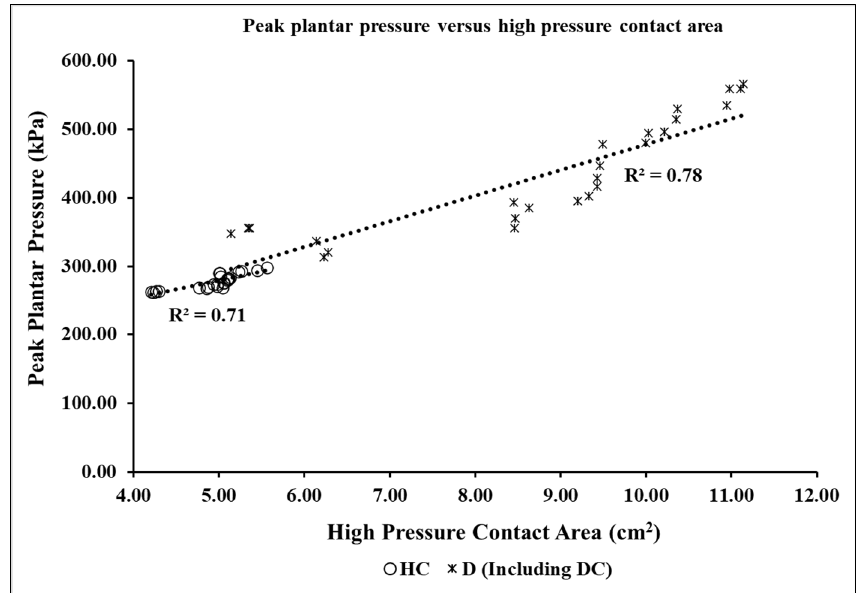
Figure 13. Correlation plot between the high-pressure contact areas and the peak plantar pressures across the HC and D (including the DC) volunteer groups, while standing.